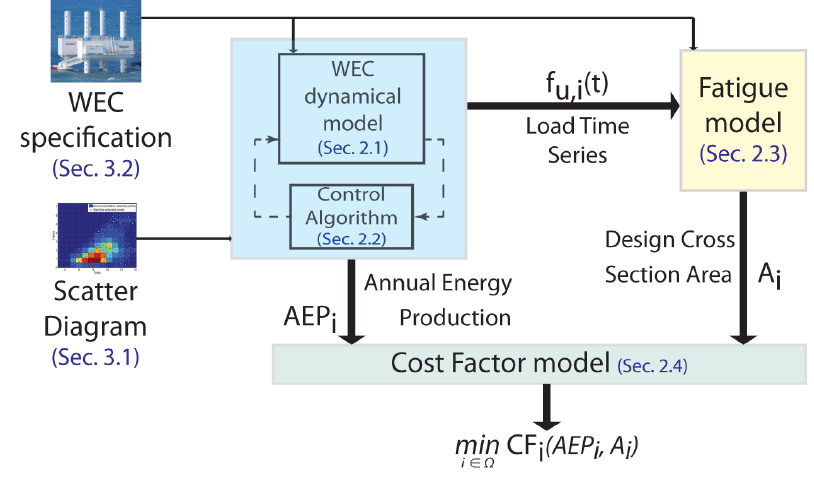
Figure 1. Work flow diagram of the proposed methodology. Subscript “ i ” refers to the i -th-control strategy and Ω defines the set of the selected control strategies. WEC: wave energy converter; and AEP: annual energy